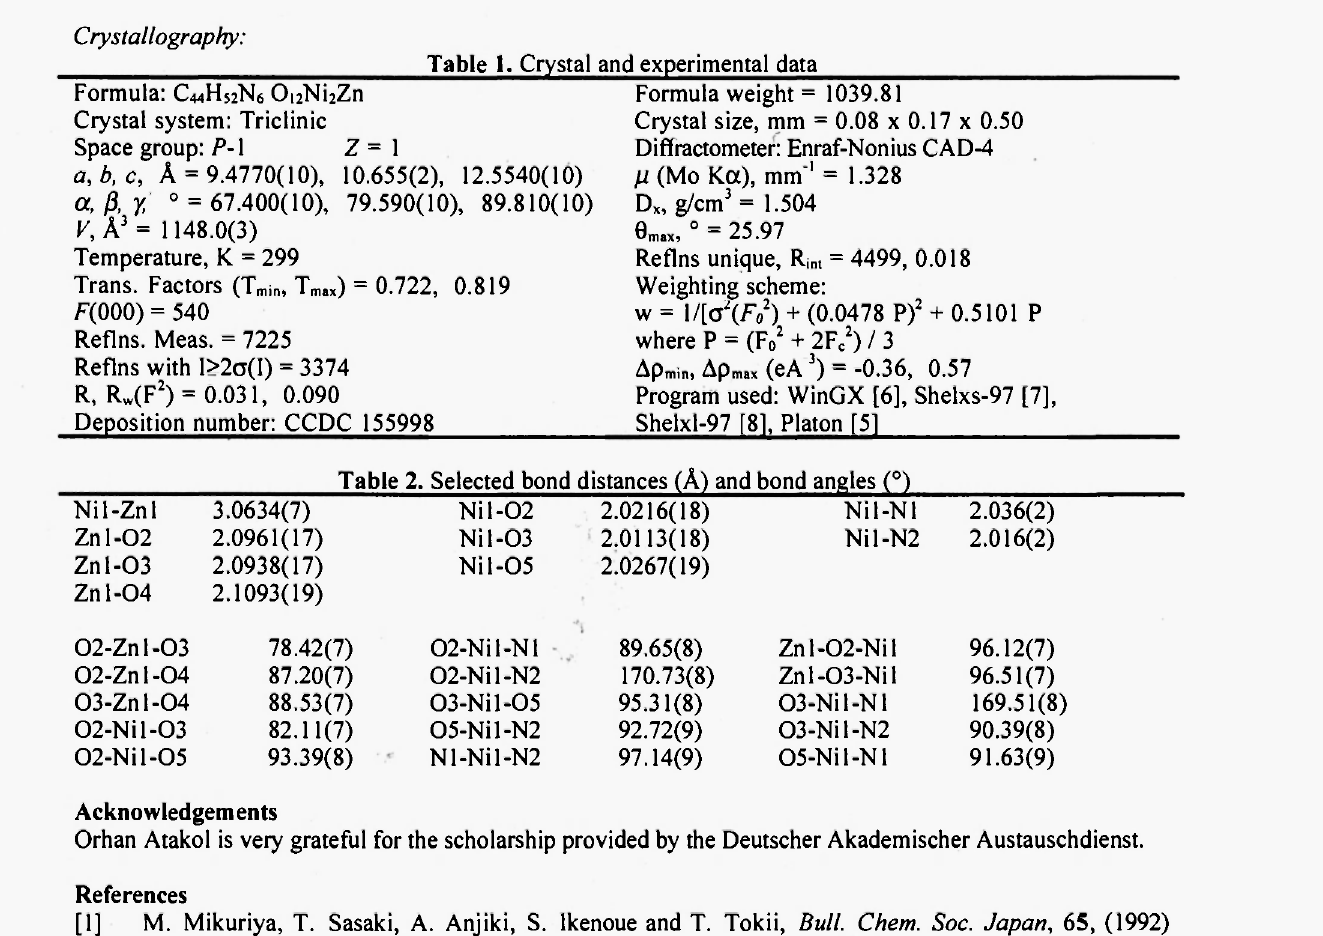
Table 2. Selected bond distances (A) and bond angles